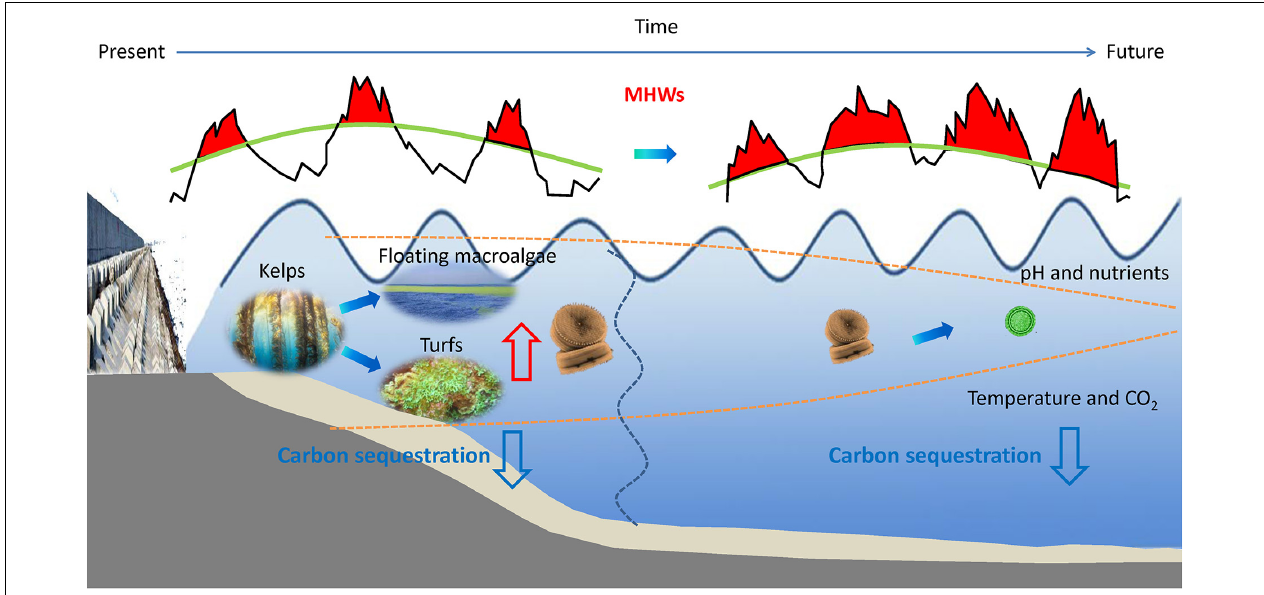
FIGURE 2 | Illustration of the hypothesis on the alteration of algal structure and carbon sequestration in future oceans. MHWs combined with ocean warming and acidification would facilitate the survival of turfs, floating macroalgae and diatoms in coastal oceans, and smaller cyanobacteria in open oceans; carbon sequestration by marine primary producers is predicted to decrease due mainly to the decreased primary production and carbon sink rates. Red arrow represents a rising trend and blue arrows represent a decreasing